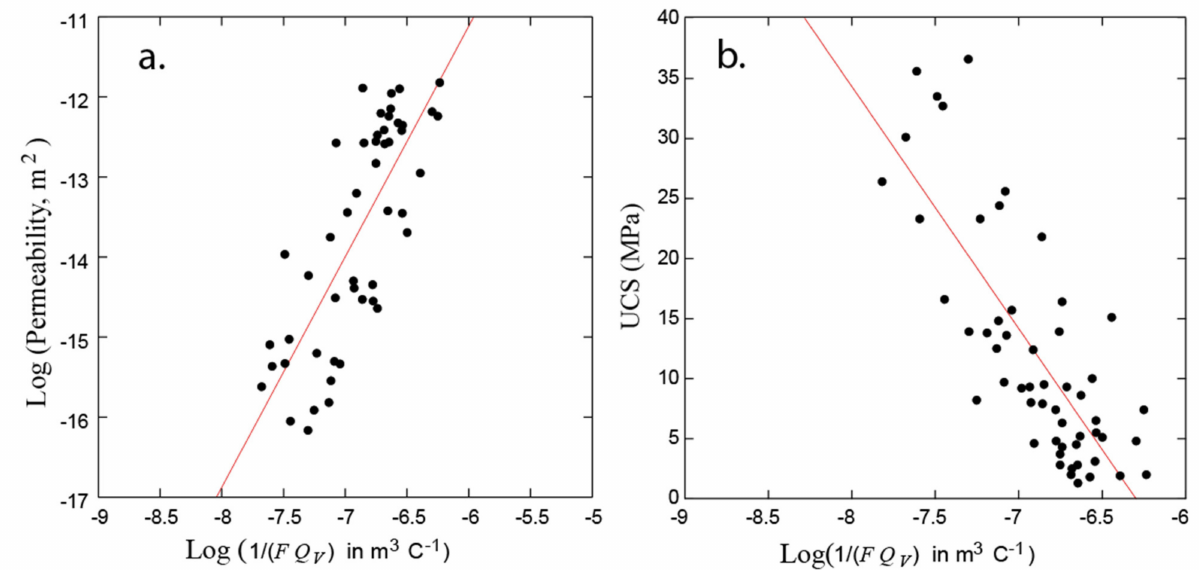
Figure 20. Prediction of permeability ( k ) and Uniaxial Compressive Strength (UCS) from an alteration index based on porosity and CEC ( F denotes the formation factor and Q V the excess of charge of the electrical double layer per unit pore volume). ( a ) Permeability as a function of alteration index for the rock samples from Whakaari (New Zealand). The coefficient of correlation is r 2 = 0.60. The fitted parameters are discussed in the main text. The values of the empirical parameters defined above are given by k 0 = 1.46 × 10 6 (log k 0 = 6.17 ± 2.35) and c = 2.88 ± 0.34, for our collection of volcanic rocks. ( b ) Uniaxial compressive strength (UCS) as a function of alteration indicator (see text for details) for the rock samples from Whakaari (New Zealand). The coefficient of correlation is R 2 = 0.61. The fitted parameters are a = − 20 ± 2 and b = − 127 ± 15 (modified from